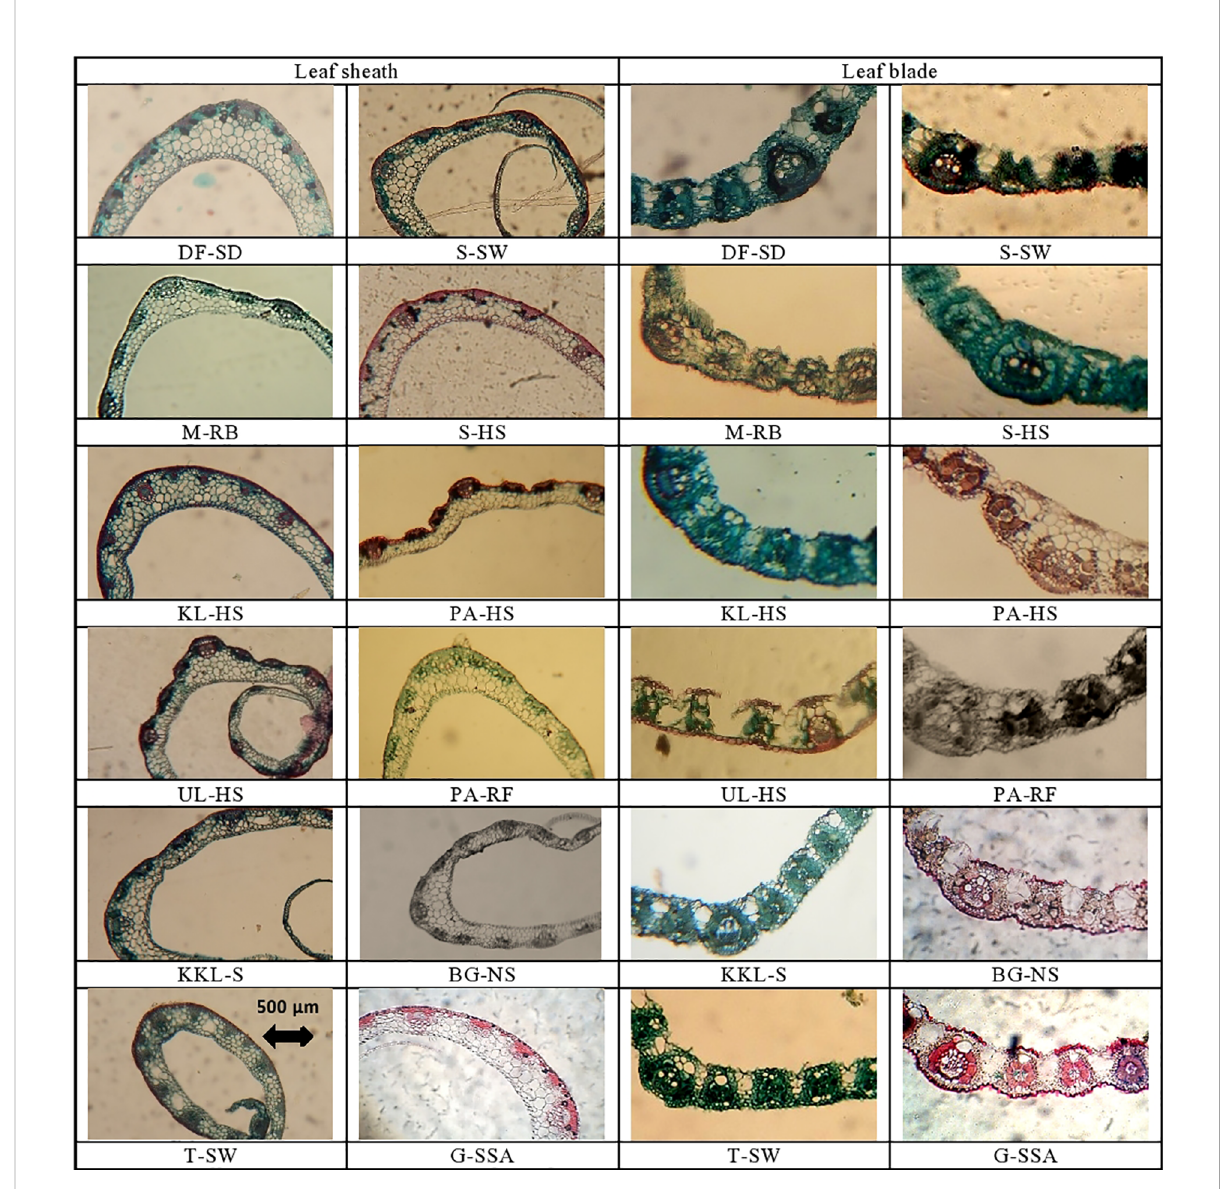
FIGURE 4 Leaf sheath and leaf blade transverse section of cynodon dactylon ecotypes collected from the Punjab, Pakistan. DF-SD, Derawar fort-saline dessert; M-RB, Muzaffar garh-River bank; KL-HS, Khabbeki Lake-hyper saline; UL-HS, Ucchali Lake-hyper saline; KKL-S, Kalar Kahar Lake-saline; T-SW, Treemu-wetland; S-SW, Sahianwala-saline wetland; S-HS, Sahianwala-hyper saline; PA-HS, Pakka Anna-hyper saline; PA-RF, Pakka Anna- reclaimed fi eld; BG-NS, Botanic Garden-non saline; G-SSA, Gatwala-saline